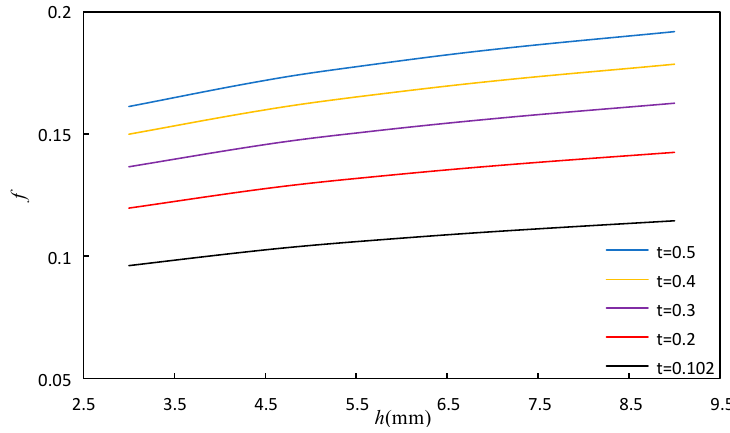
Figure 13. Effect of fin height and fin thickness on f . Figure 13. E ff ect of fi n height and fi n thickness on f.